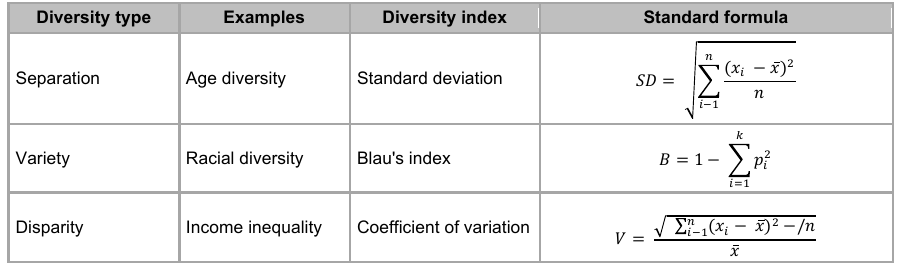
Source: Table based on Solanas et al. (2012:413) Several univariate diversity indices were constructed based on gender, age, race and qualifications. For gender, a categorical data set with only two categories, the ranking of boards was based on the proportion of women directors on the different boards. Blau’s index was calculated as well,